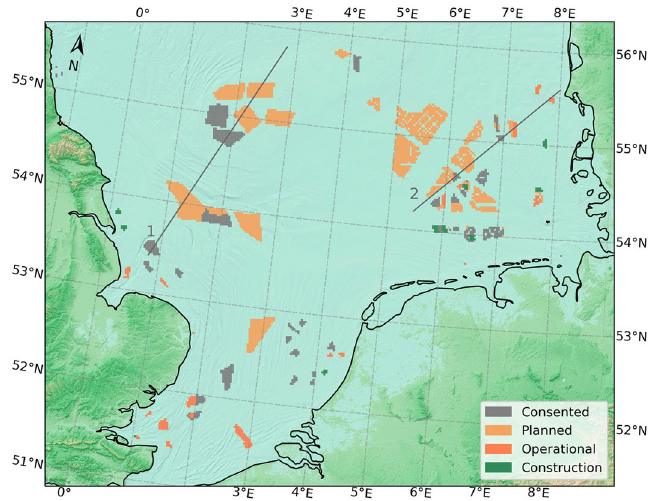
Figure 1. Scenario configuration for OWFs used for model scenario-based OWFs in the North Sea 1 . Colored polygons indicate the planning status of the OWFs by 2015 in the North Sea and the land-sea mask of the model domain. Gray lines indicate the transects used for analysis. This figure was created with Matplotlib (Hunter, J. D., Matplotlib: a 2D graphics environment. Computing in Science and Engineering 9, 2007) and Cartopy (Met office, Cartopy: a cartographic python library with a matplotlib interface. Exeter, Devon, https:// scito ols. org. uk/ carto py,